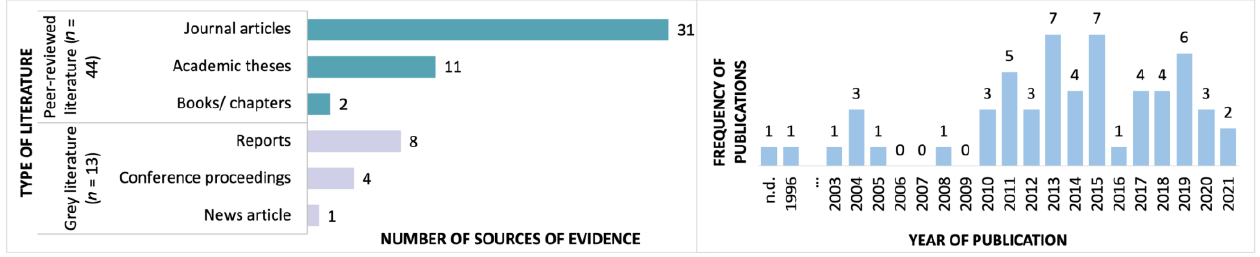
Figure 2. Year published and type of publication.